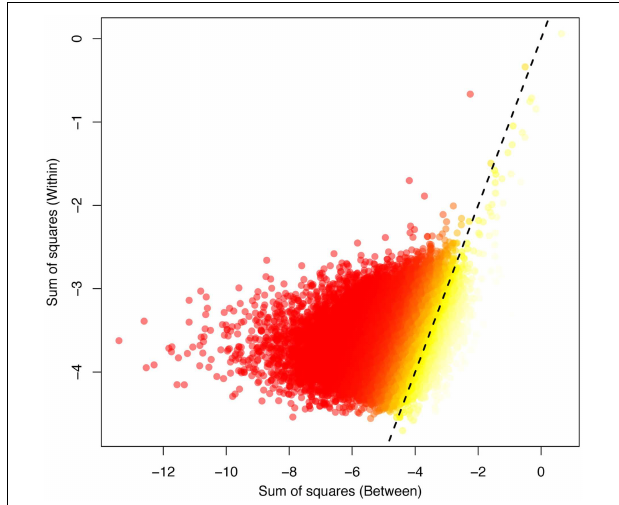
FIGURE 2 | The between-variation (human-chimp) plotted against the within-variation (human) obtained for the ANEVA. The highest F ST values are indicated in yellow, corresponding to the most divergent peaks between the species, with low F ST values indicated in red. The dotted line indicates the 1:1 correspondence between the